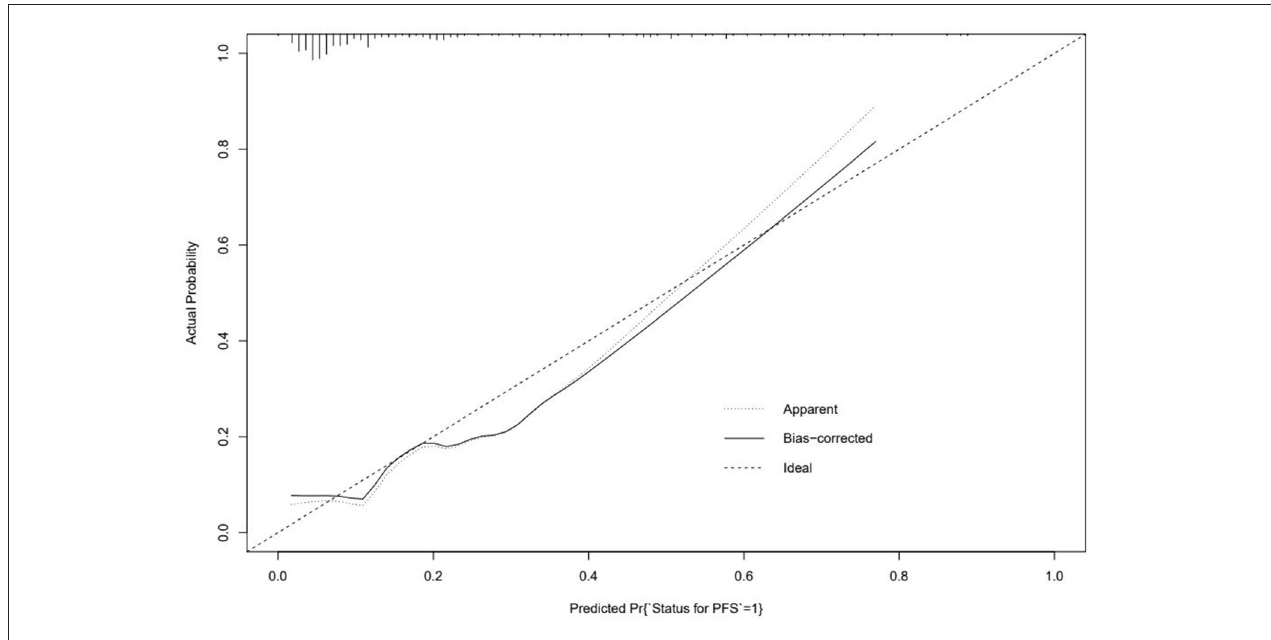
FIGURE 7 | Calibration curve of the prediction model.